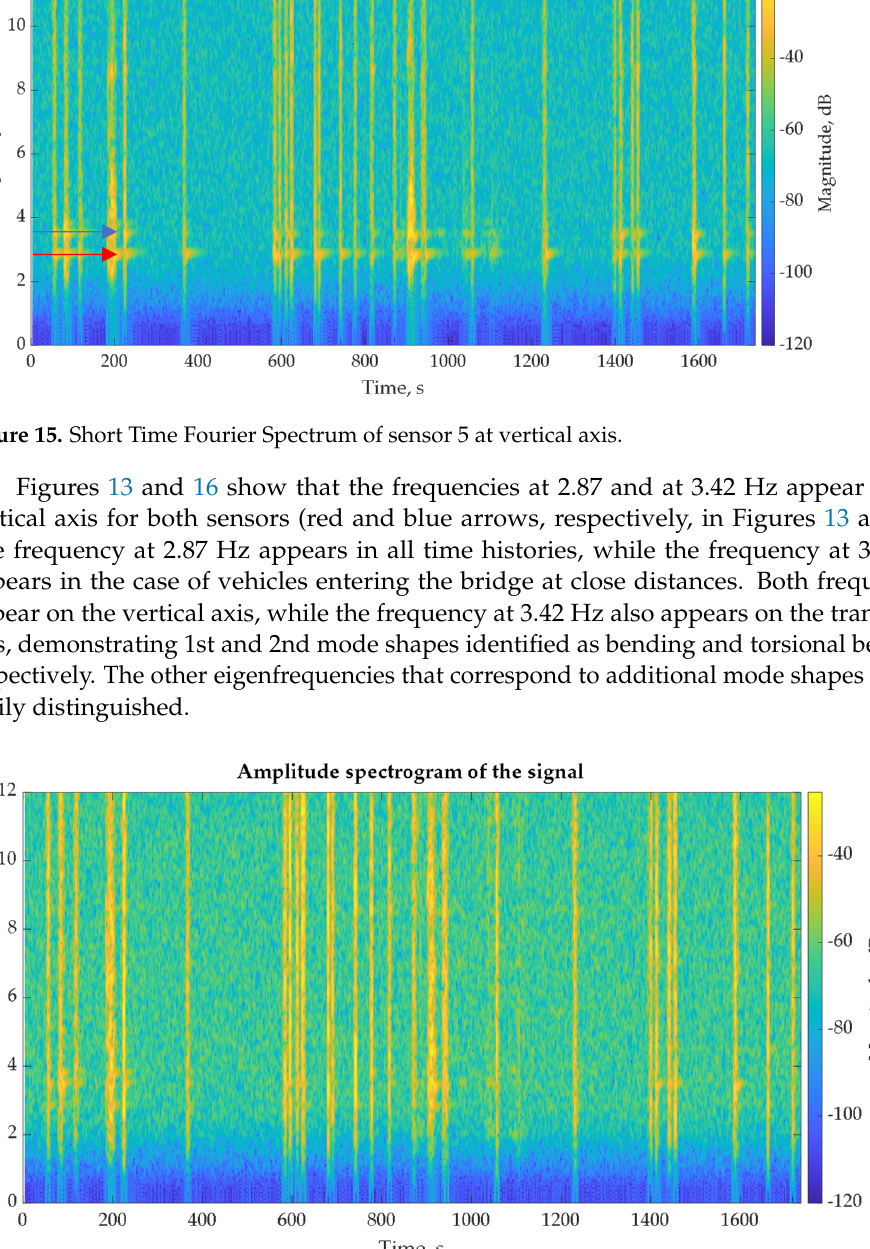
Figure 16. Short Time Fourier Spectrum of sensor 5 at transverse axis (Y